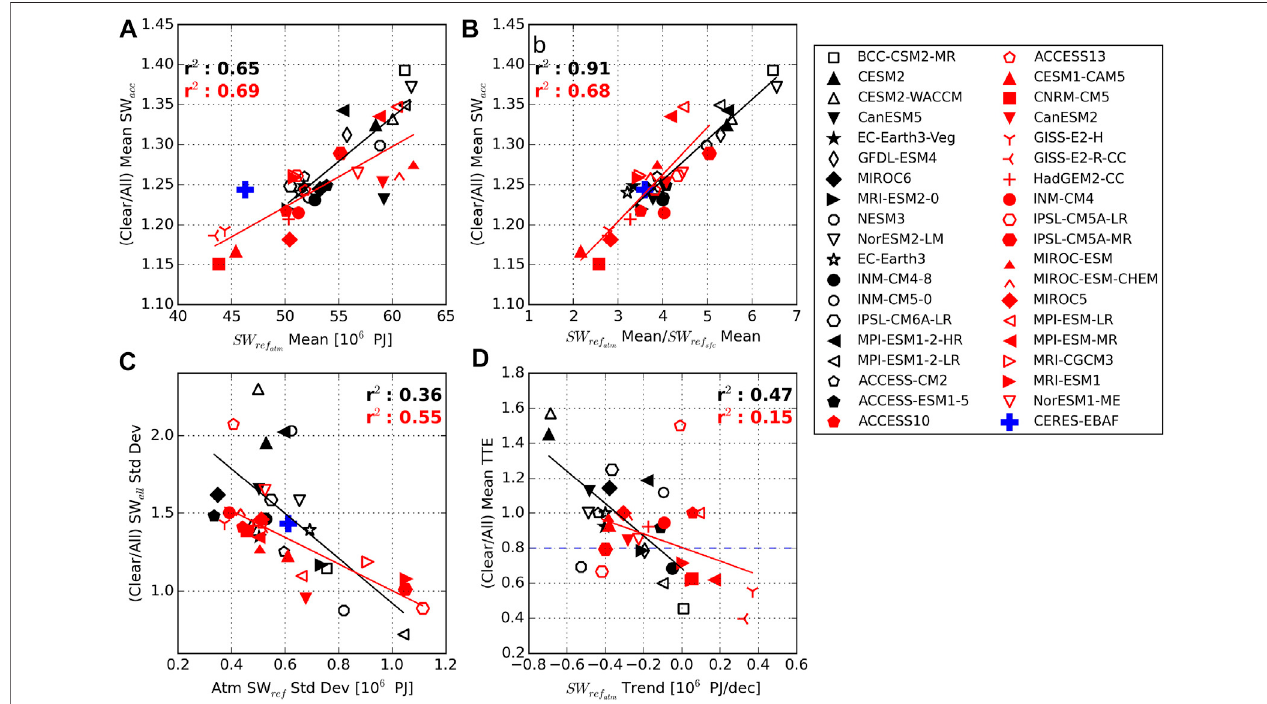
FIGURE 10 | Total SW re fl ected due to the atmosphere ( SW ref ) as it relates to accumulated SW (SW acc ) ratios of all-sky to clear-sky for (A) means, (B) standard atm deviations,and (C) trendsandtimetoemergence(TTE).Meansandstandarddeviationsarecalculatedover2000 – 2014,andtrendsandSW acc TTEarecalculatedusing SSP585 over 2000 – 2100 for CMIP6 (black) and RCP8.5 for CMIP5 (red). CERES observations are shown for values calculated over 2000 – 2014. Wherever possible, similar symbols have been adopted for models from the same